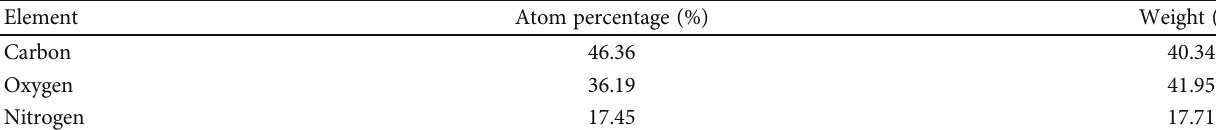
Table 1: EDX plot data summery of NGQD nanoparticle.